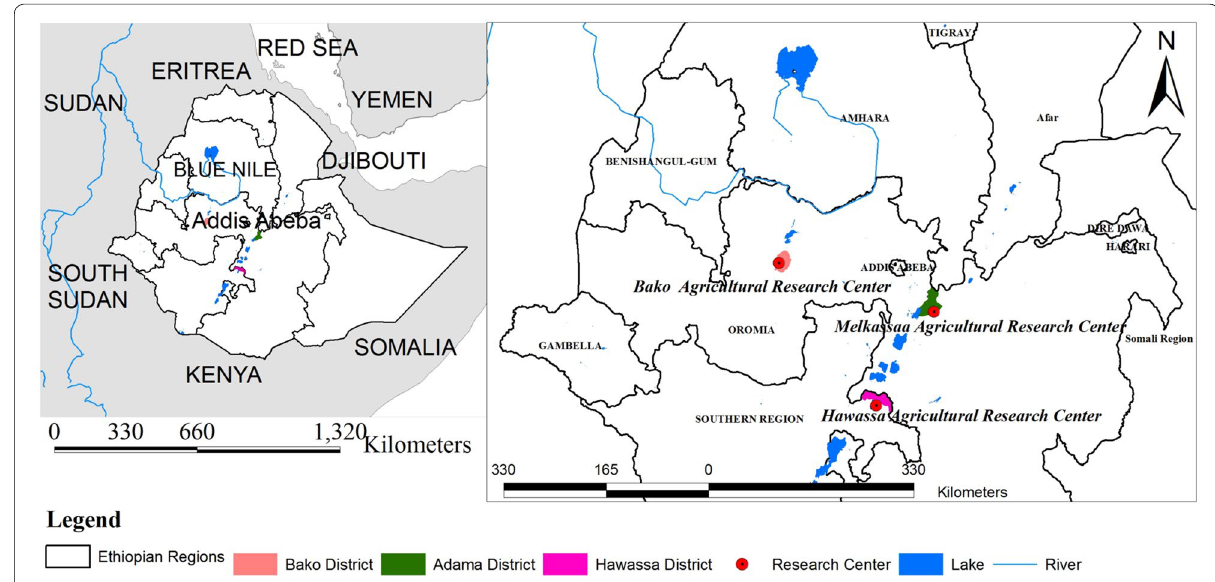
Fig. 1 Location map of Ethiopia administrative regions, the three study districts and agricultural research centres